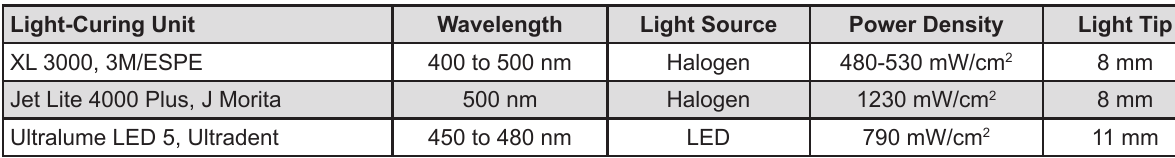
Figure 2- Description of tested light curing